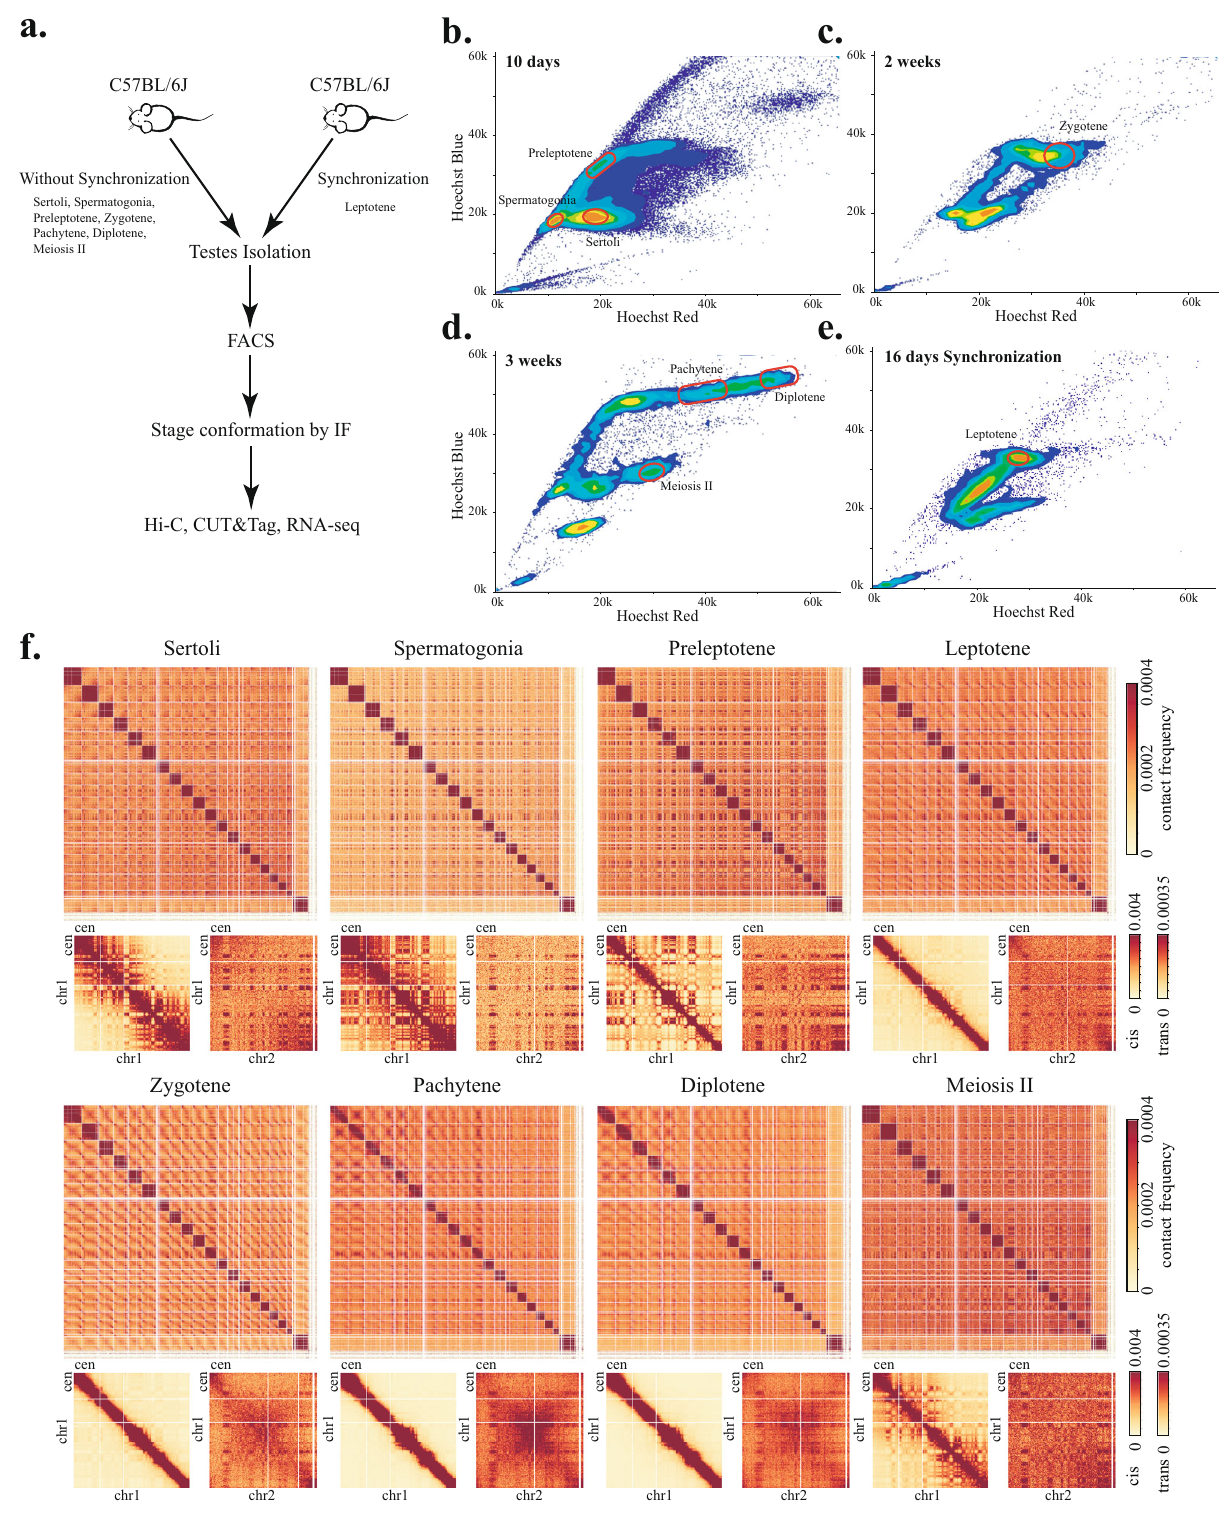
Fig. 1 Mapping 3D genome architecture through mouse spermatogenesis by Hi-C. a Experimental work fl ow for isolating somatic cells and spermatocytes of different stages. b – e Representative Hoechst pro fi les show the separation of different cell types by fl uorescence intensity in mice of different ages: 10- day-old mice for isolating Sertoli, spermatogonia, and preleptotene cells ( b ), 2-week-old mice for zygotene cells ( c ), 3-week-old mice for pachytene, diplotene, and meiosis II cells ( d ), 16 days synchronized mice for isolation of leptotene cells ( e ). Red circles in each pro fi le indicate gating windows used for cell isolation. f Genome-wide Hi-C interaction heatmaps binned at 1 Mb resolution show dynamic reorganization of 3D genome architecture during meiosis. Enlarged Chr1 and Chr1 – Chr2 trans interaction heatmaps at 1 Mb resolution are shown below the genome-wide heatmaps. Cen indicates the centromere ends of